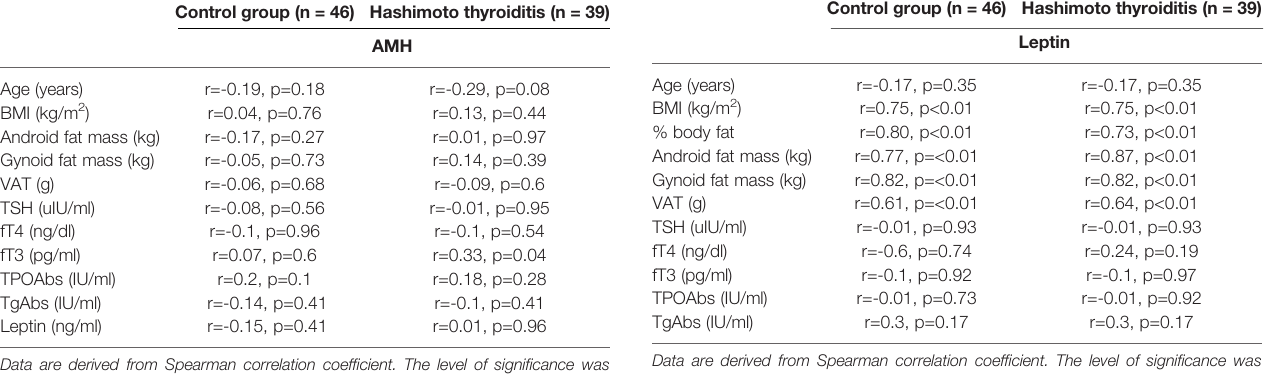
TABLE 3 | The relationship between clinical, biochemical, and hormonal parameters and leptin serum concentration in Hashimoto thyroiditis patients and the control